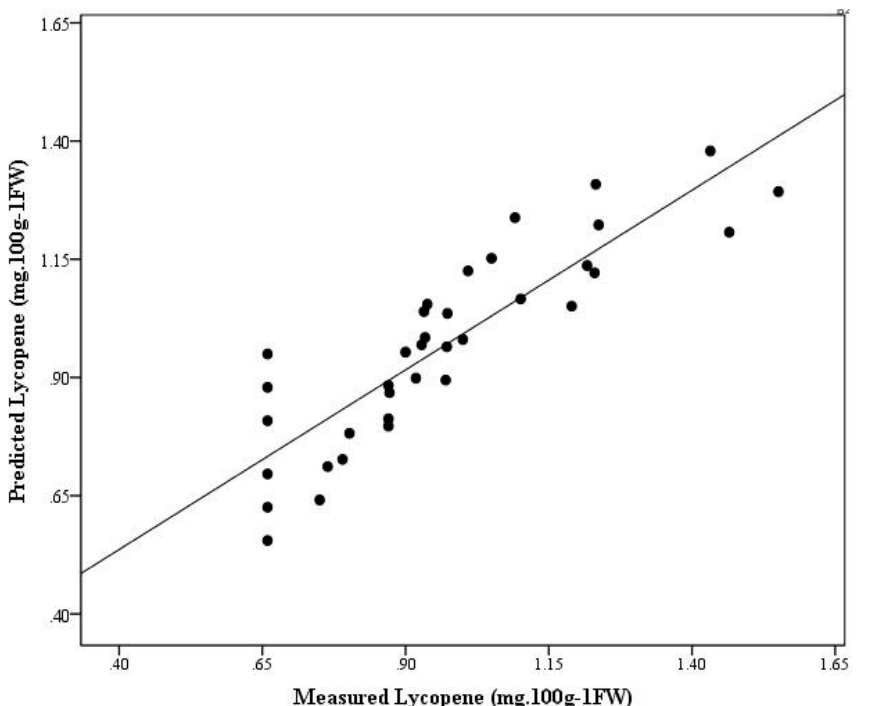
Figure 13. Results for the prediction of lycopene values based on linear regression models.